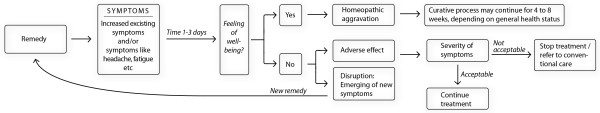
Relationship between homeopathic aggravation, adverse effects and disruptions.